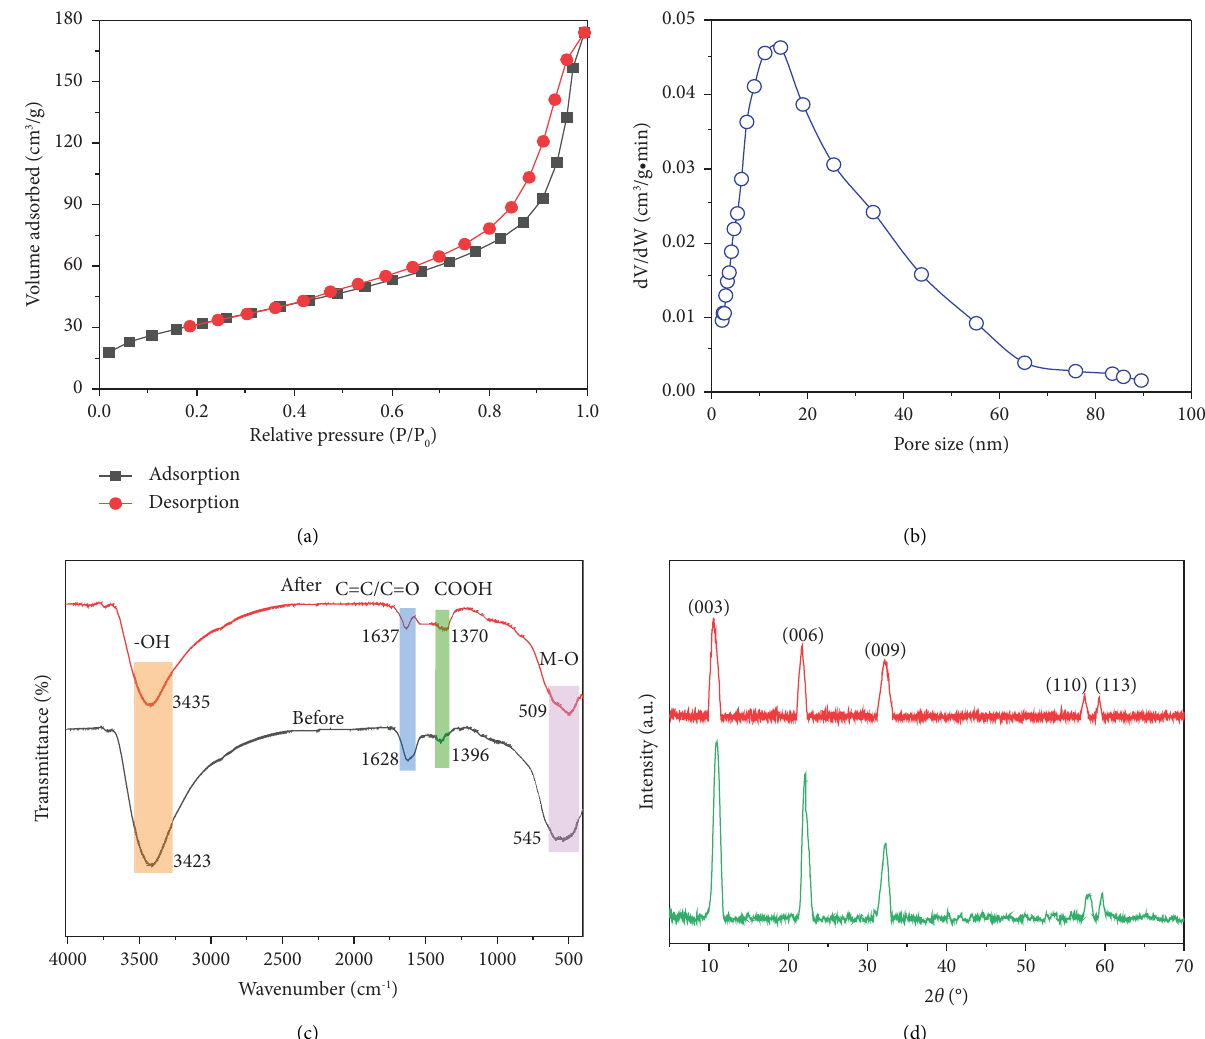
Figure 2: N 2 adsorption-desorption curves (a), pore size distribution (b), FTIR (c), and XRD (d) of